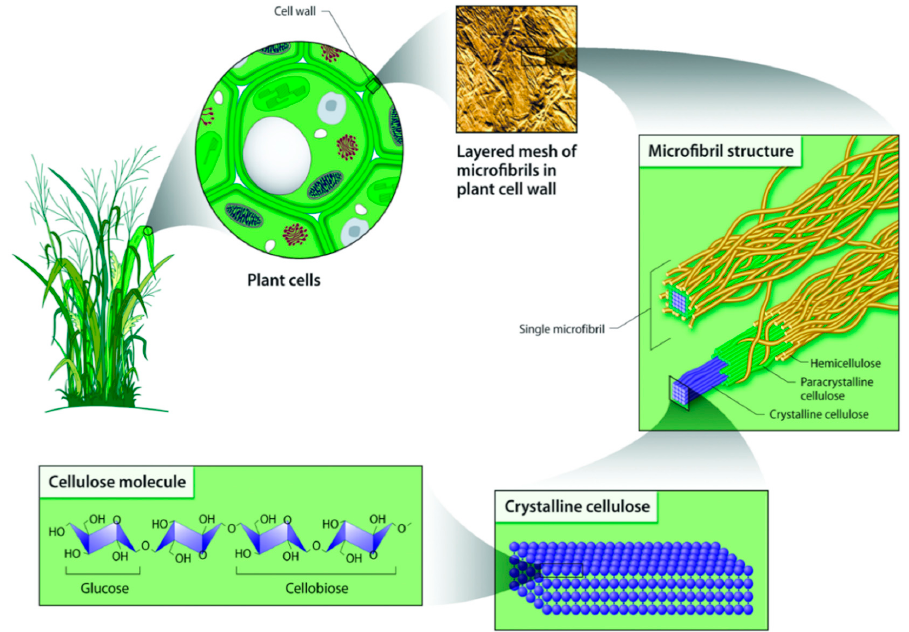
Figure 7. The inside structure of a plant cell wall. Hemicelluloses and lignin protect cellulose from breakdown.